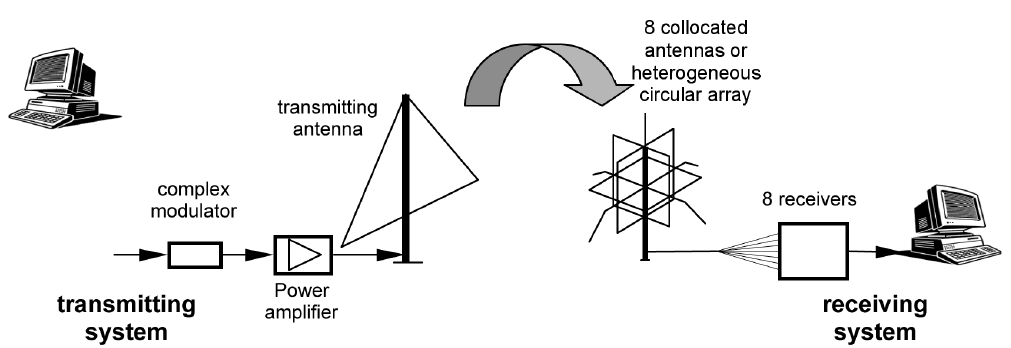
Fig. 13.9. Schematic of the Poitiers-Monterfil